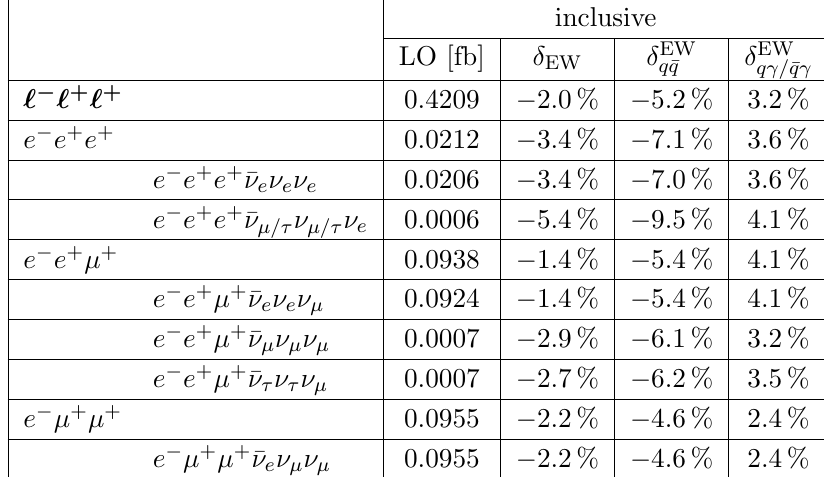
Table 4 . Inclusive cross section and electroweak corrections in the (cid:12)ducial region de(cid:12)ned by the cuts of table 3. The remaining processes can be obtained by replacing e (cid:6) table